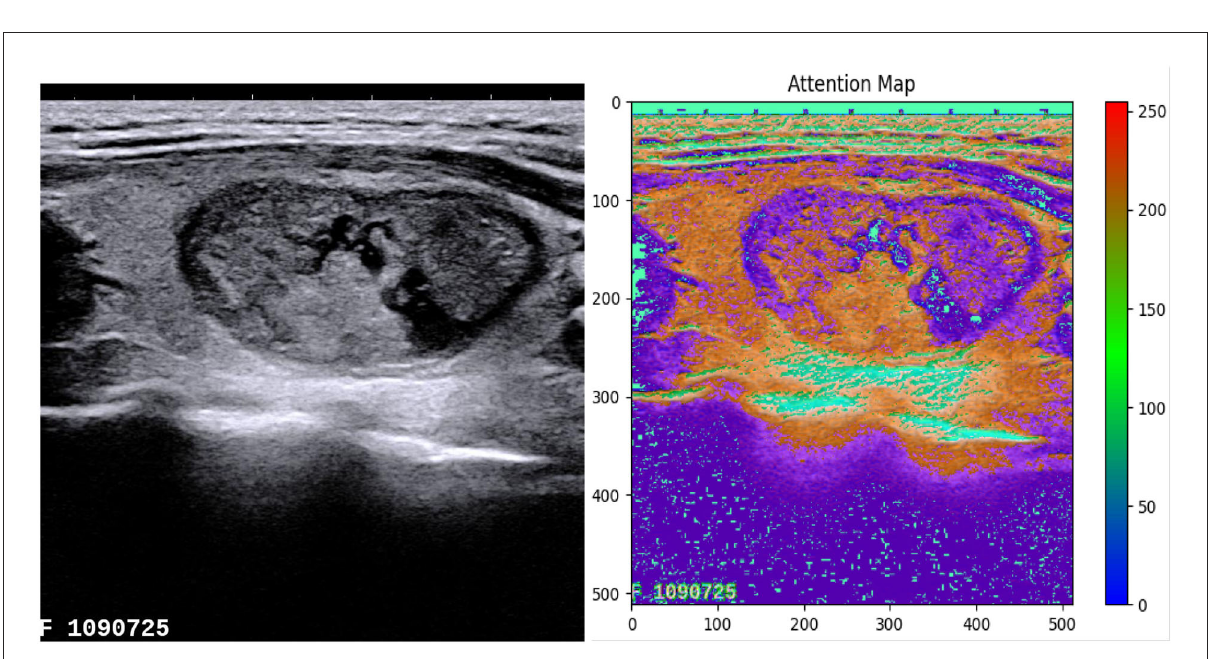
FIGURE3 The attention map highlights the foreground region of the thyroid